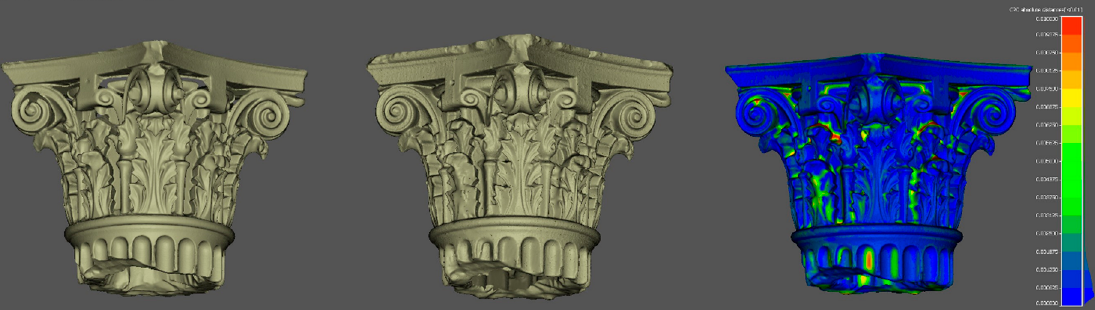
Figure 4. Scanning results. Untextured Stonex F6 SR mesh ( left ), untextured FARO Focus 3D X 330 mesh ( center ) and scalar field mapping of Hausdorff distances; maximum visualized distance: 1 cm.